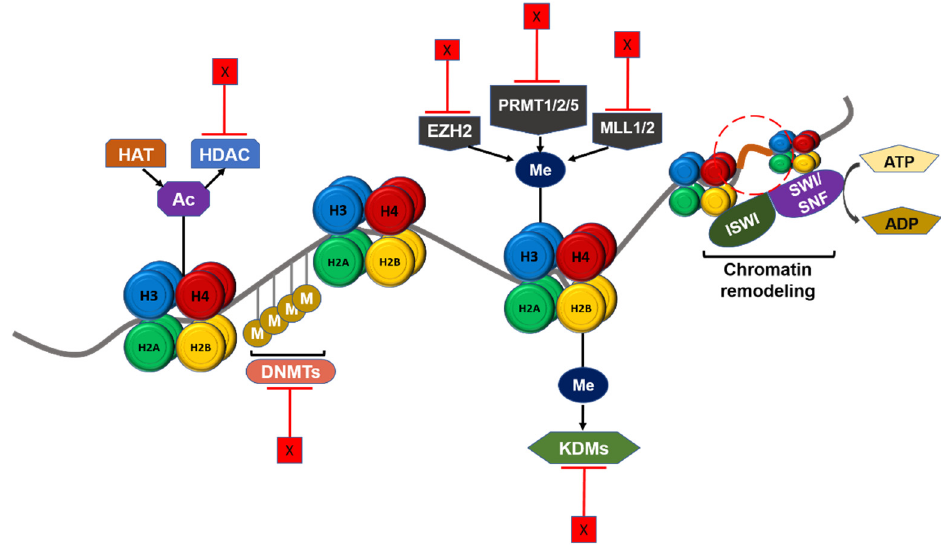
Figure 3. Schematic summary of epigenetic regulation in GBM and potential therapeutic targets. Chromatin structure and gene transcription are regulated by epigenetic mechanisms. DNA methyl- transferase (DNMT), histone lysine acetyltransferase (HAT), and histone lysine methyltransferase (KMT) such as EZH2, PRMTs, and MLL1/2 catalyze the addition of epigenetic groups to either DNA or histone tails. Histone deacetylase (HDAC) and histone demethylase (KDM) remove these epige- netic groups. ISWI and SWI/SNF complex could remodel chromatin structure according to histone modifications. These regulators can be targeted in therapeutic treatment against GBM, and further- more the targets shown here are either under pre-clinical studies or approved and under clinical trials. Ac: Acetyl group. M/Me: Methyl group. X: Inhibition. Table 1. Development of combination therapy using epigenetic drugs for the treatment of GBM